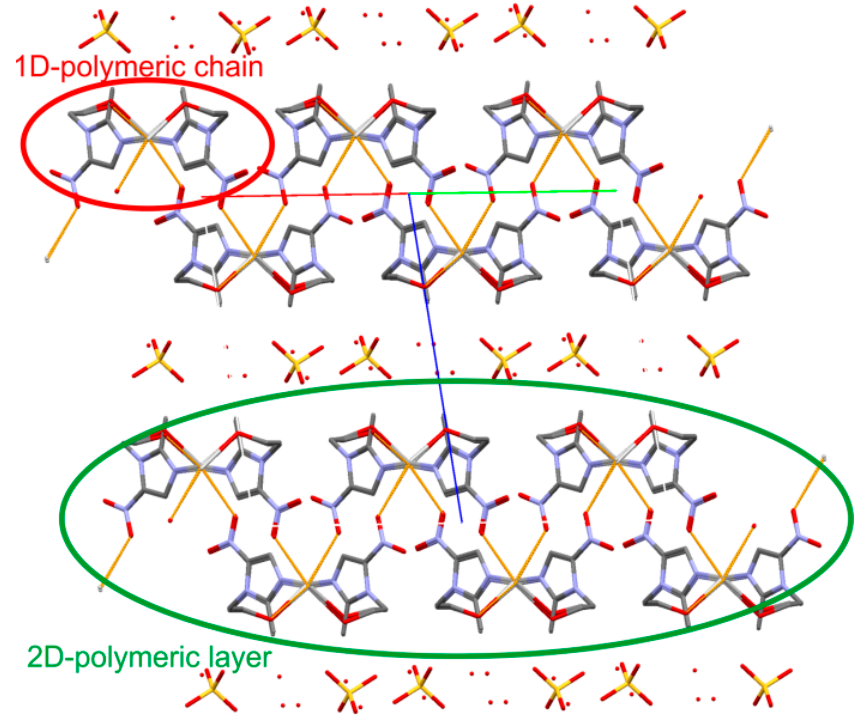
Figure 4. The crystal packing of the title complex. Figure 5. The crystal packing of the title complex.